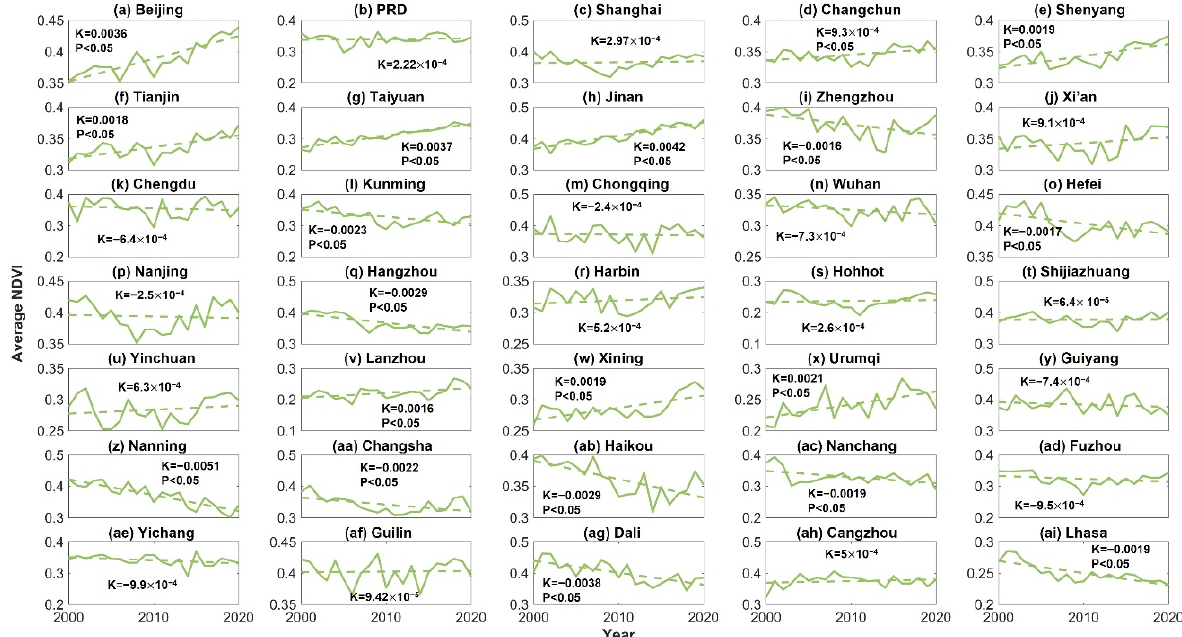
Figure 2. Temporal variations of NDVI in selected 35 cities of China from 2000 to 2020. Megacities ( a – c ), megapolis ( d – q ), big cities ( r – ad ), mid-sized cities ( ae , af ), and small cities ( ag – ai ). Marked ‘ p < 0.05’ means the city NDVI through 5% level significance